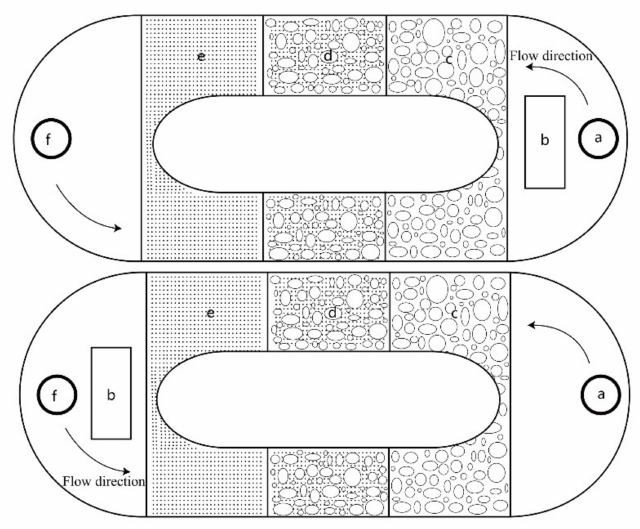
Figure 2. Diagrammatic sketch of the riverbed substrate reference experiment. ( a , b , f ) The water inlet, water pump, and outlet, respectively; ( c – e ) three types of substrate: pebbles, pebbles blended with sand, and pure sand,